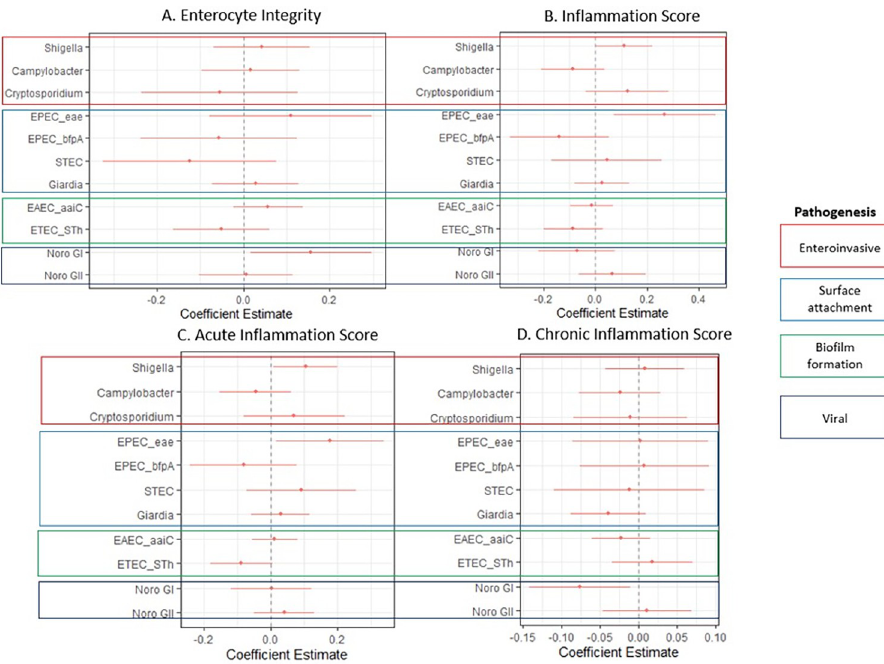
Fig 3. Associations between the theory driven score and stool pathogen gene counts; (a) associations between stool pathogen gene counts and the Enterocyte Integrity Score, (b) associations between the overall Inflammation Score and stool pathogen gene counts, (c) the associations between stool pathogen gene counts and Acute Inflammation, and (d) associations between the Chronic Inflammation Score and stool pathogen counts.